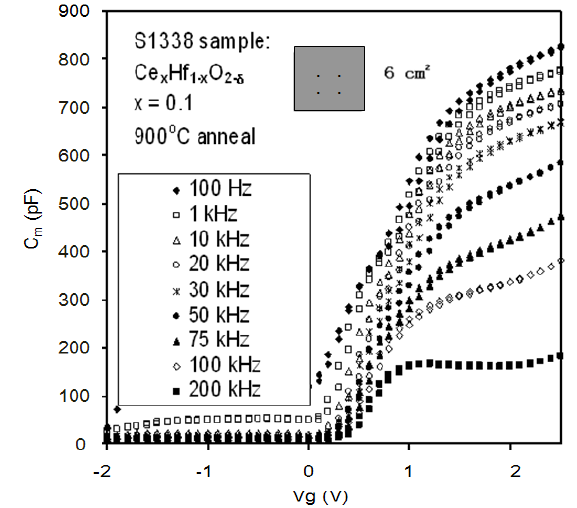
Figure 6. Causes of frequency dispersion during C-V measurement in the high- k thin film were the parasitic effect (including back contact imperfection resistance R S’ and capacitance C S’ , cables resistance R S” and capacitance C S” , substrate series resistance R and depletion layer capacitance of silicon C (interfacial layer capacitance C roughness effect, polysilicon depletion effect, high- k capacitance C , the lossy interfacial layer capacitance C G h C consists of the high- k capacitance C ox